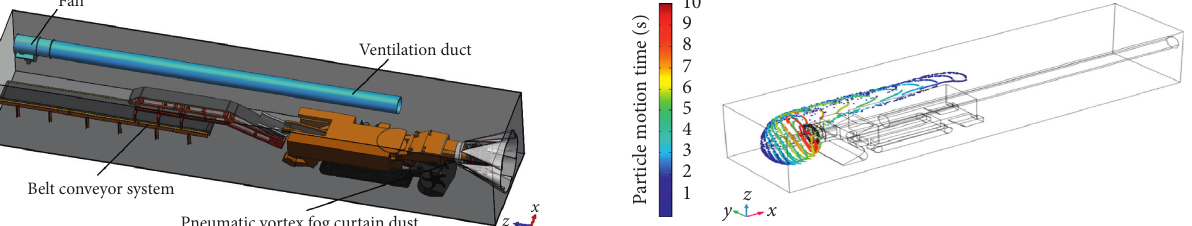
Figure 16: Particle trajectory with an air volume of 5 m 3 /min.